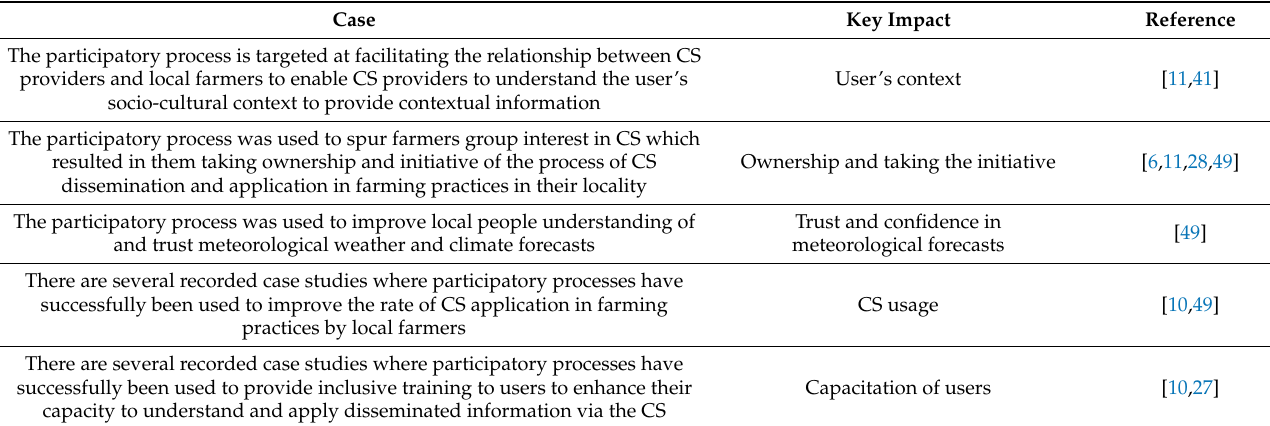
Table 4. Evidence of participatory process influence in CS